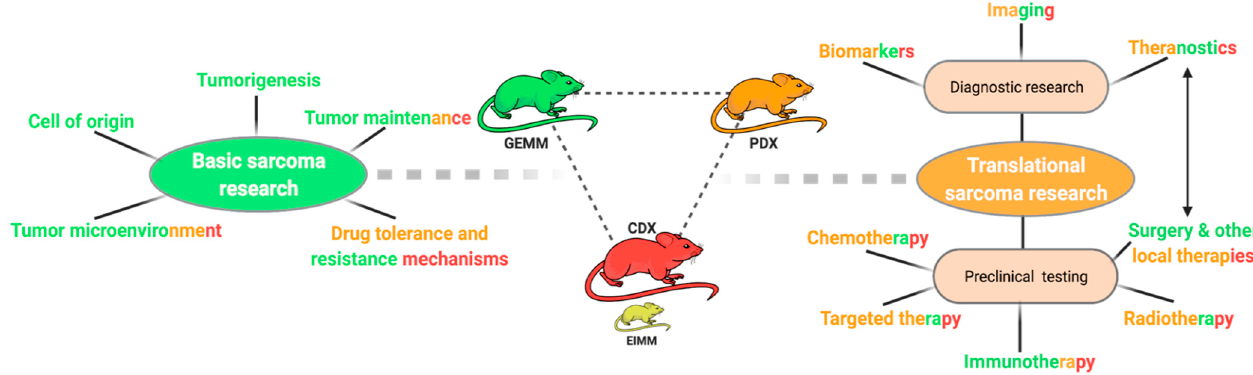
Figure 5. Utilization of sarcoma mouse models. Schematic overview of different research questions in sarcoma research. Color codes represent the generally most suitable modeling approach for the respective research field ((green) = GEMM, (orange) = PDX, (red) = CDX).